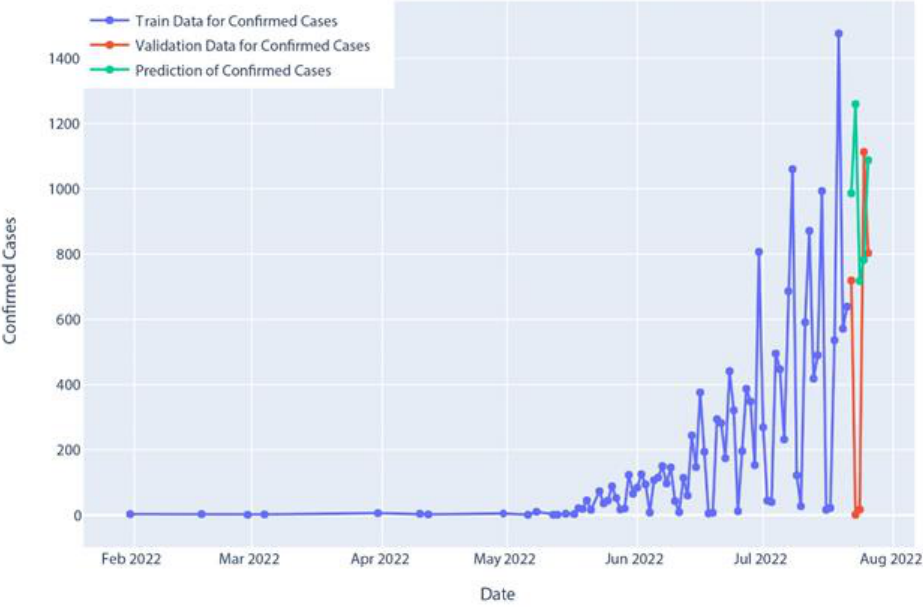
Figure 19. Confirmed cases of AR model prediction.